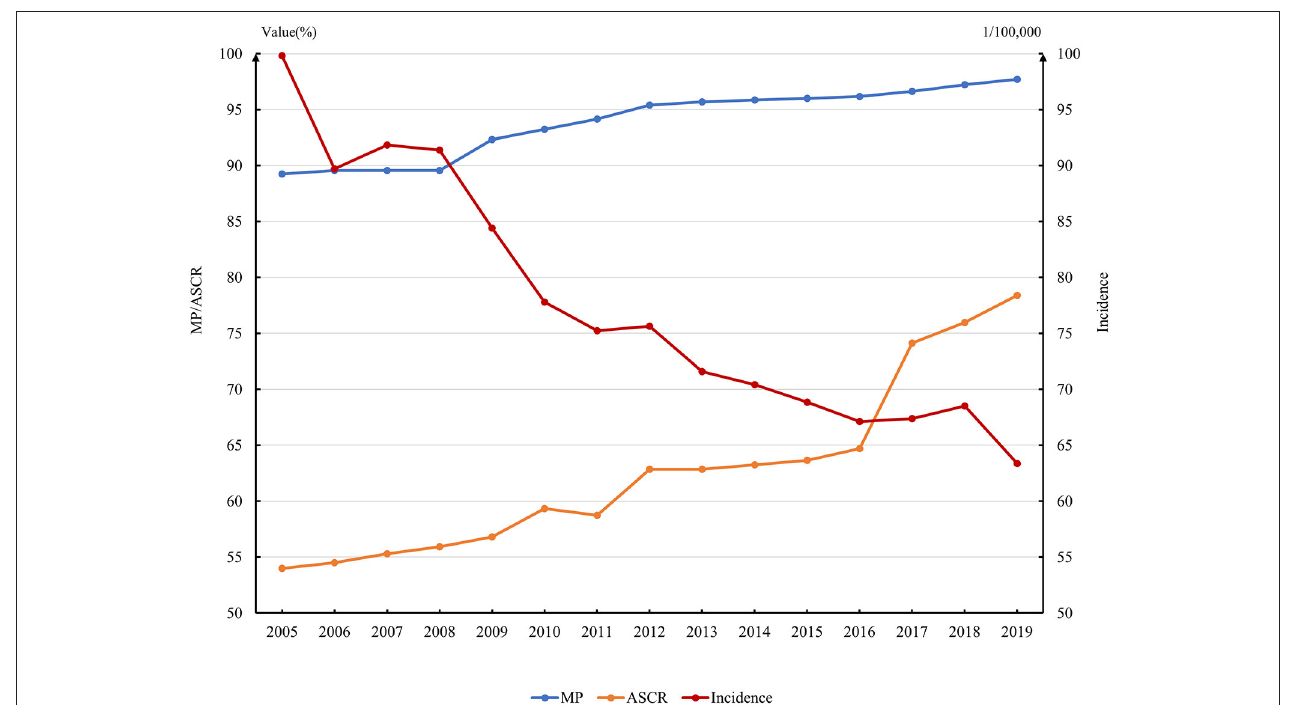
FIGURE 1 | Annual variation of MP, ASCR, and Incidence in 31 provinces in China.